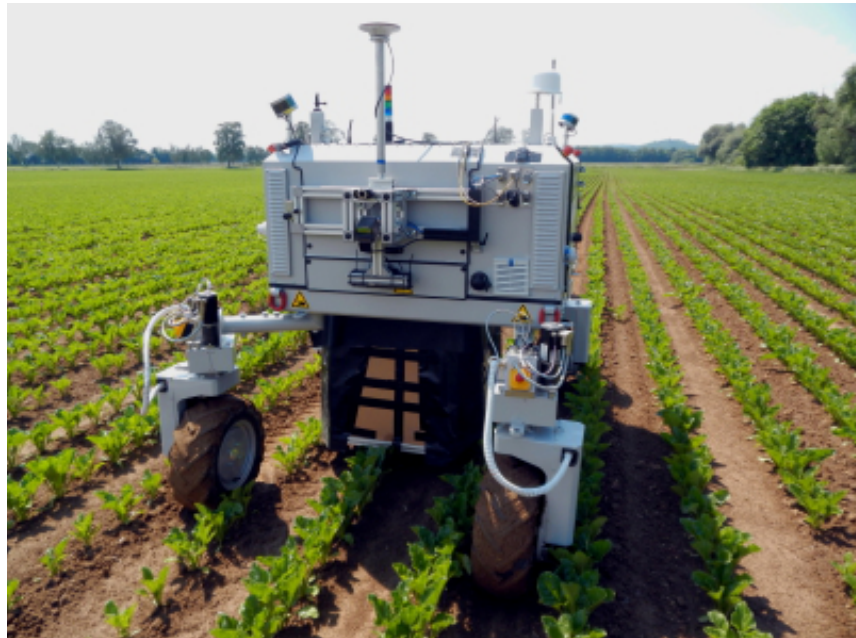
Figure 2. Acquisition process of the Sugar Beets dataset using the BoniRob terrestrial robot developed by Bosch DeepField Robotics [15]. BoniRob is equipped with four wheels that can be steered independently of each other, allowing flexible movement and navigation on rough